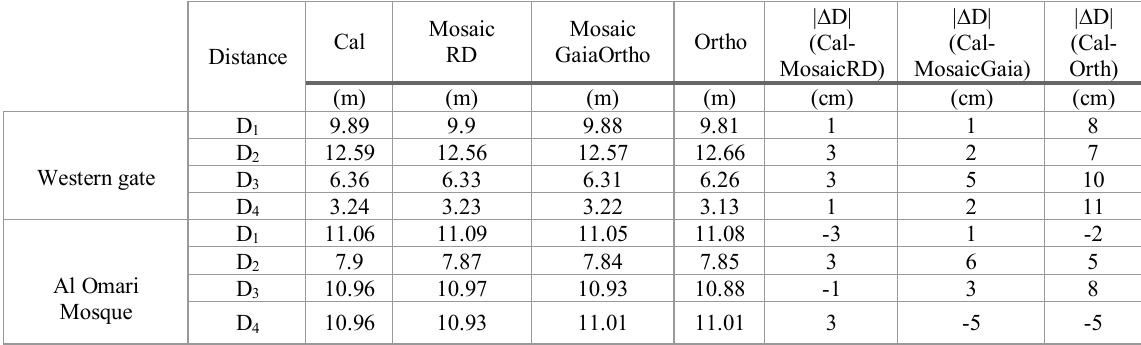
Table 7. Differences between calculated distances, measured on Raster design & GaiaOrtho photomosaics and on orthophotos respectively